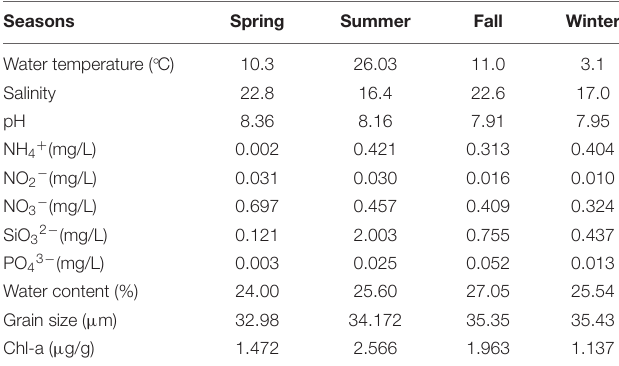
TABLE 1 | Sediments and pore water physical and chemical